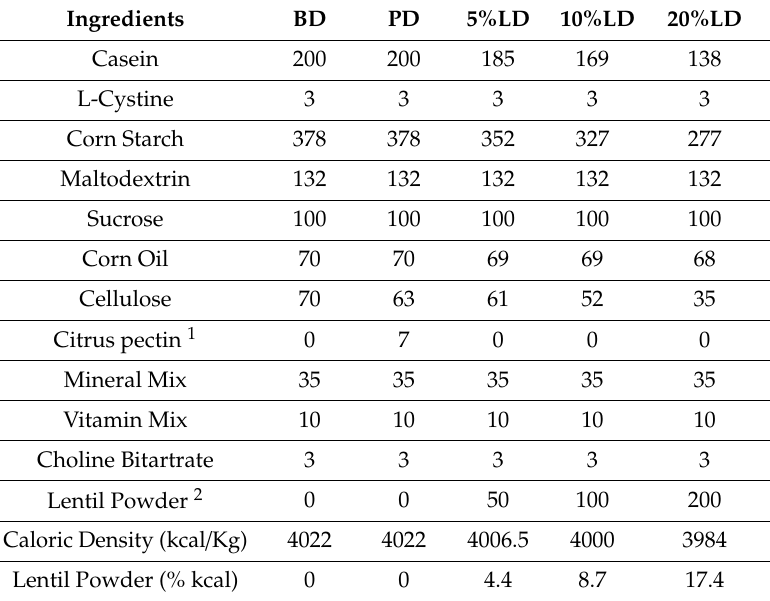
Table 1. Experimental Diet Composition [g /